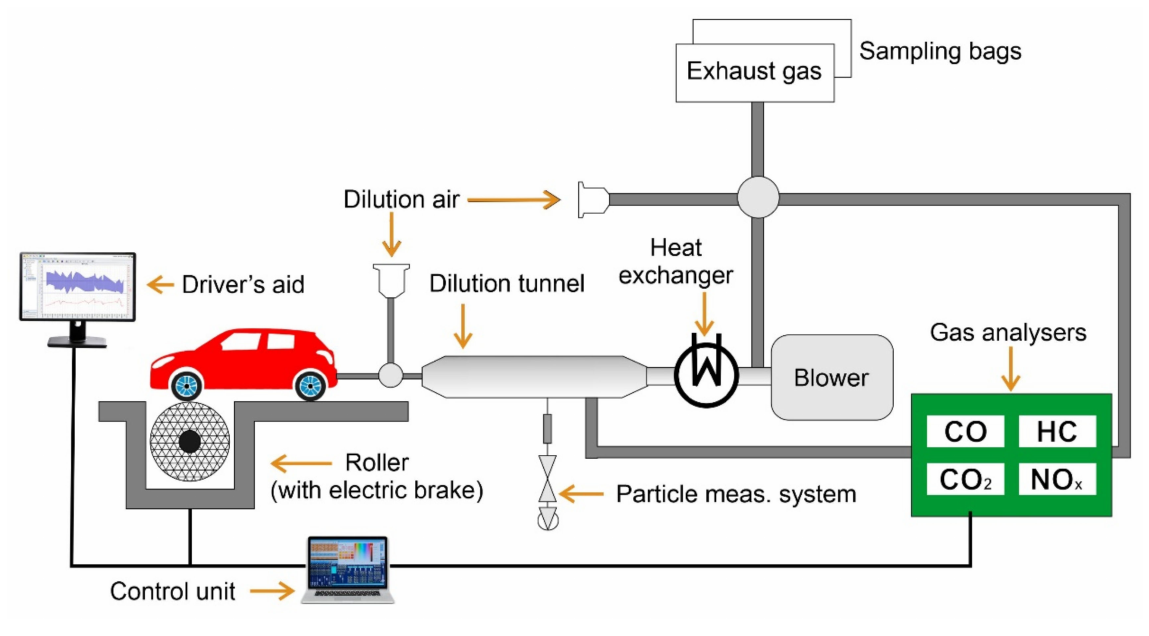
Figure 3. Typical chassis dynamometer testing setup. Table 1. Merits and demerits of testing of heavy-duty vehicles in different dynamometer setups [35,47]. Test